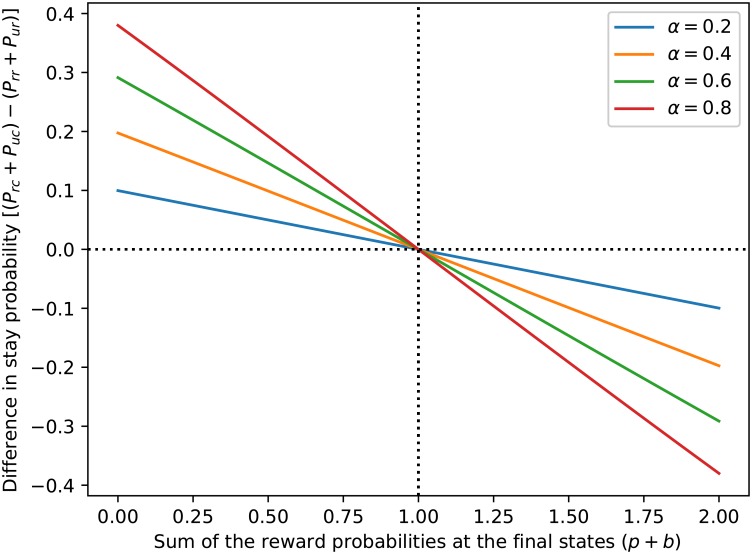
Difference in stay probability for model-based agents.Differences between the sum of the stay probabilities for model-based agents following common versus rare transitions (i.e., the sum of the dark gray bars minus the sum of the light gray bars) as a function of the sum of the reward probabilities at the final state (p + b). This specific example plot was generated assuming that final state reward probabilities are equal (p = b) and that the exploration-exploitation parameter in Eq 16 is β = 2.5. When computing the differences in stay probability on the y-axes, Prc stands for the stay probability after a common transition and a reward, Puc is the stay probability after a common transition and no reward, Prr is the stay probability after a rare transition and a reward, and Pur is the stay probability after a rare transition and no reward.